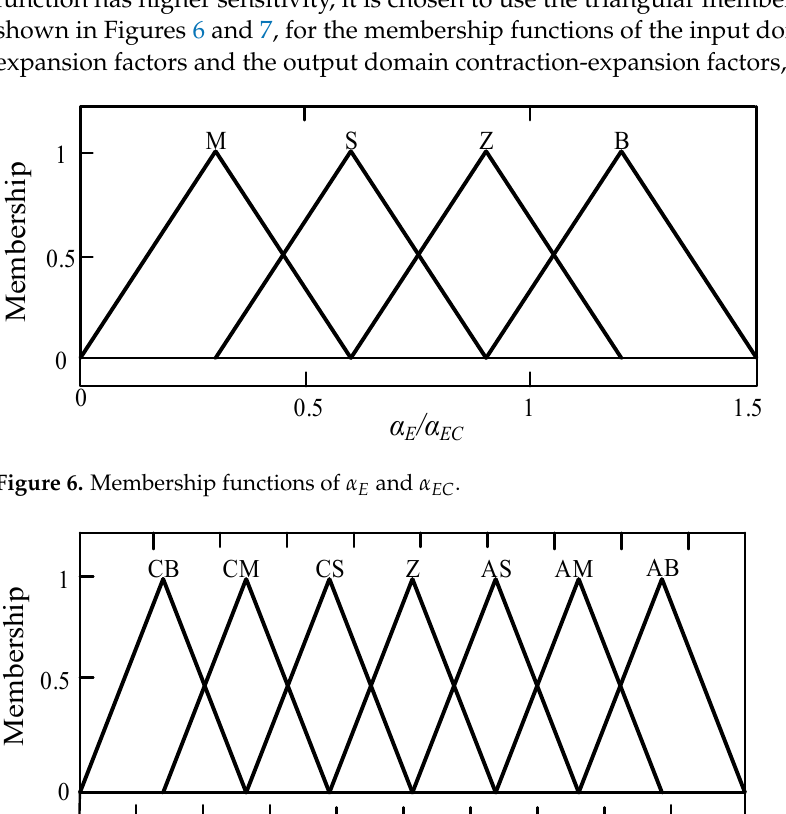
Table 3. Fuzzy control rules table of α e , α ec